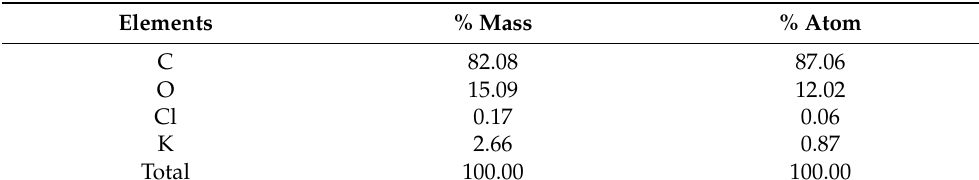
Table 2. Result of EDS analysis of activated carbon ACDS.